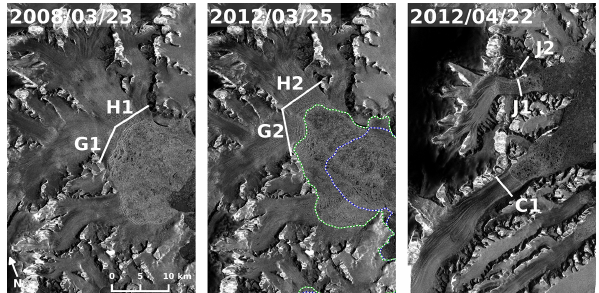
Figure 4. Section of TerraSAR-X amplitude images. Left and cen- ter: HGE glaciers on 23 March 2008 and 25 March 2012, with flux gates on Hektoria (H) and Green (G) glaciers and location of the glacier front on 24 December 2004 (dotted blue line) and 25 March 2012 (dotted green line). Right: TSX image of Crane (C) and Jorum (J) glaciers on 22 April 2012 with flux gates.